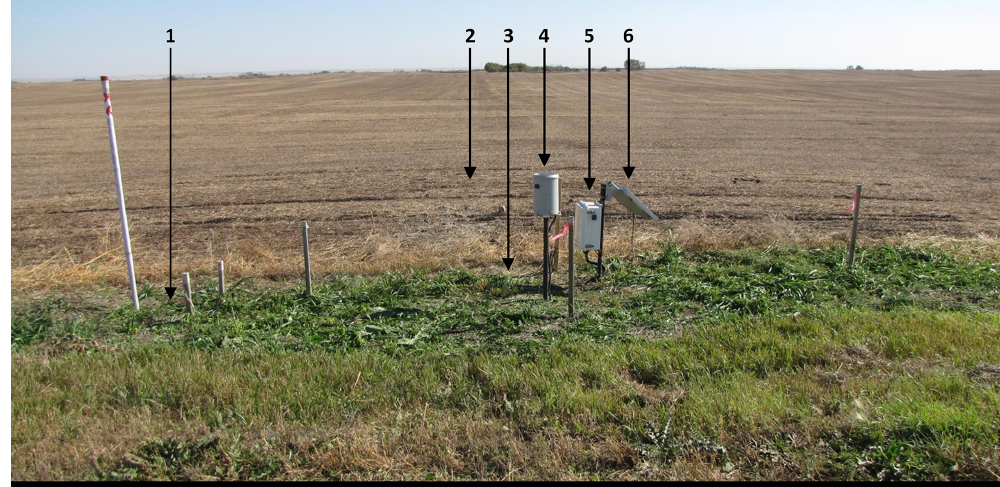
Figure 2. Typical site installation. The four-probe sites include at (1) horizontal 5cm sensor; (2) horizontal 20 and 50cm sensors and location of vertical 0–5cm sensor during field season; (3) location of vertical 0–5cm sensor during off season; (4) tipping-bucket rain gauge; (5) logger box with data logger; (6) solar panel. Only ECCC sites have a vertically placed probe. The three-probe sites are similar, with all probes located at the edge of field at (1).